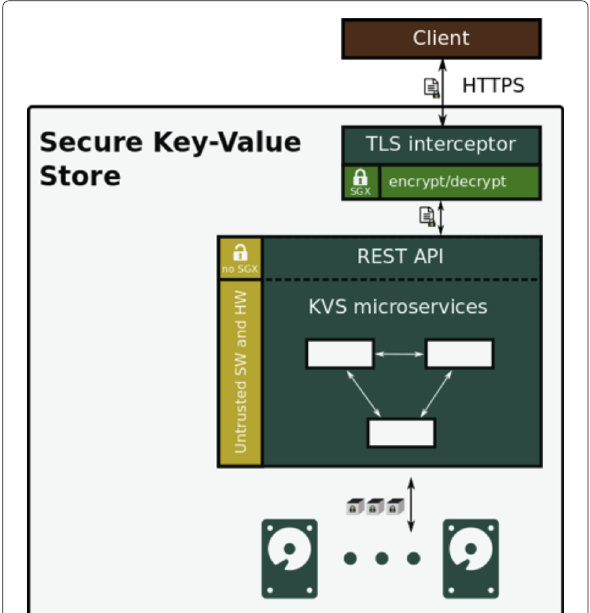
Fig. 4 Secure KVS:architecture